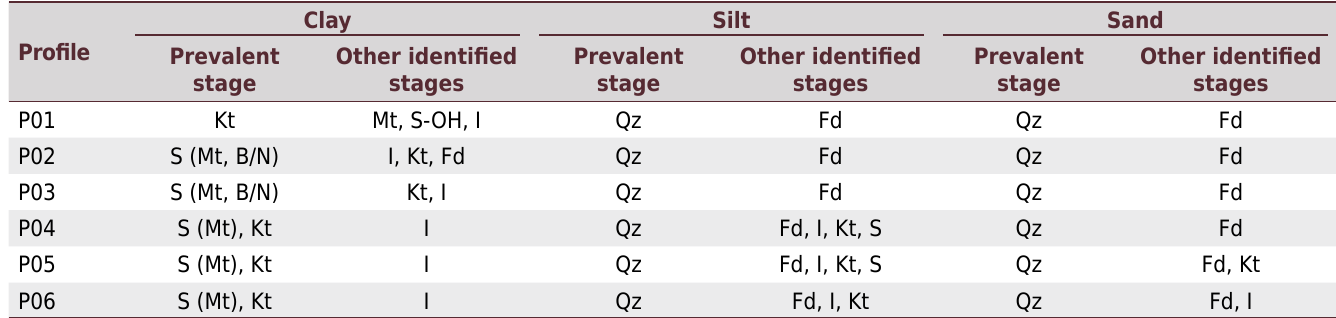
Table 4. Mineralogical composition of clay, silt, and sand fractions in Bahia State’s Vertisols Clay Profile